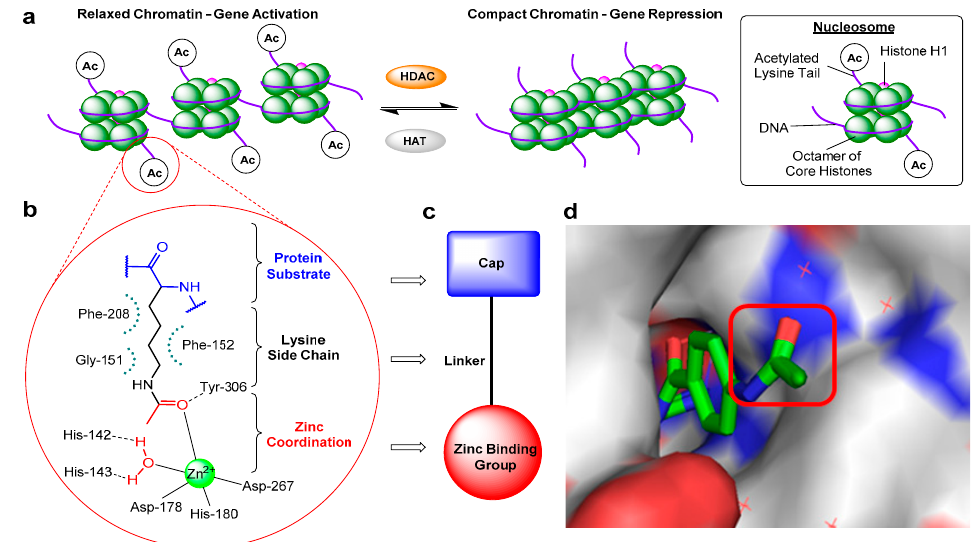
Figure 1. ( a ) Schematic diagram illustrating changes in chromatin structure due to histone deacetylase (HDAC)-catalysed deacetylation. ( b ) Representative HDAC – acetyl lysine substrate interactions in an active site. ( c ) Typical HDAC inhibitor design. ( d ) Crystal structure of o -aminoanilide HDAC inhibitor bound to HDAC2, highlighting the surface-exposed acetyl group and hence cap modification tolerance for dual inhibitor functionalisation (PDB 4LY1).